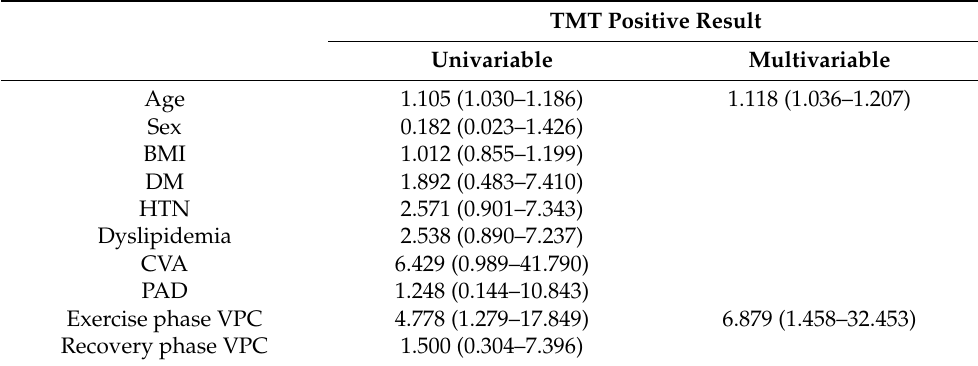
Table 2. Risk for TMT positive in exercise provoked VPC group ( n = 153, age ≤ 65).